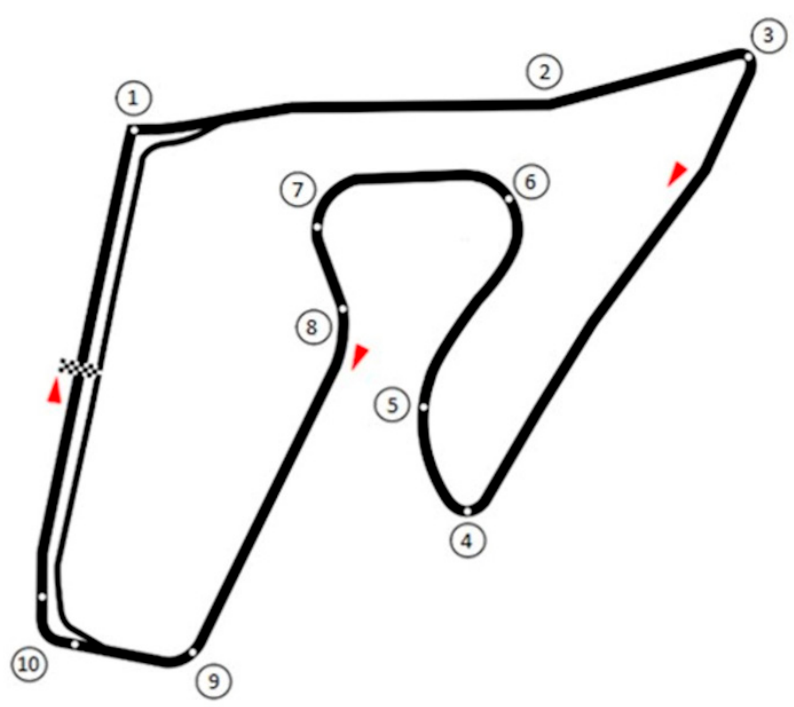
Figure 1. An overview of the Red Bull Ring circuit, Austria: points from 1 to 10 represent the turns in the track.